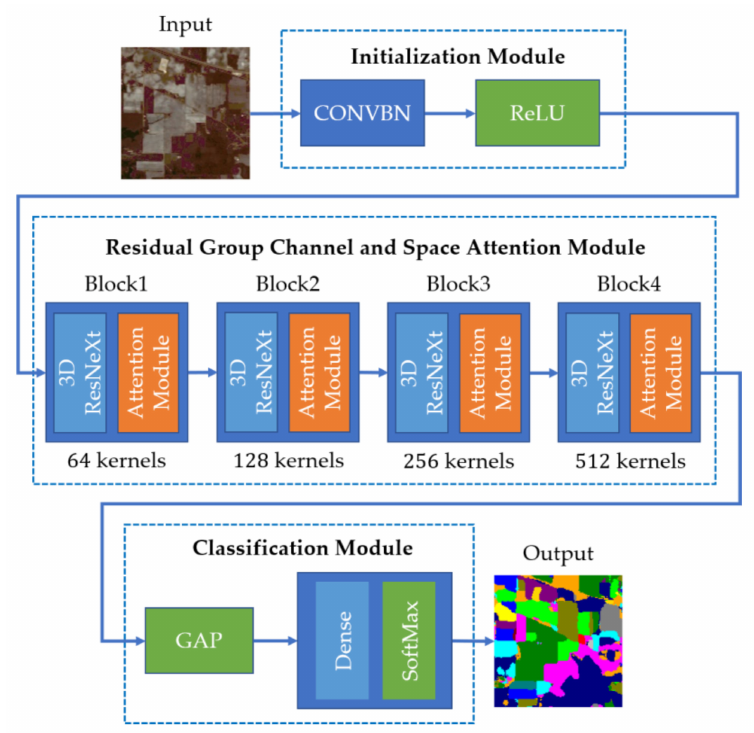
Figure 8. Overall HSI classification structure of the proposed residual group channel and space attention (RGCSA)